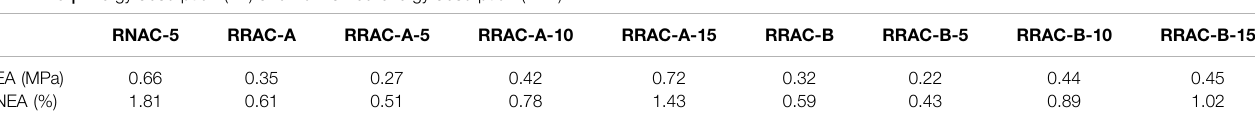
TABLE 5 | Energy absorption (EA) and normalized energy absorption